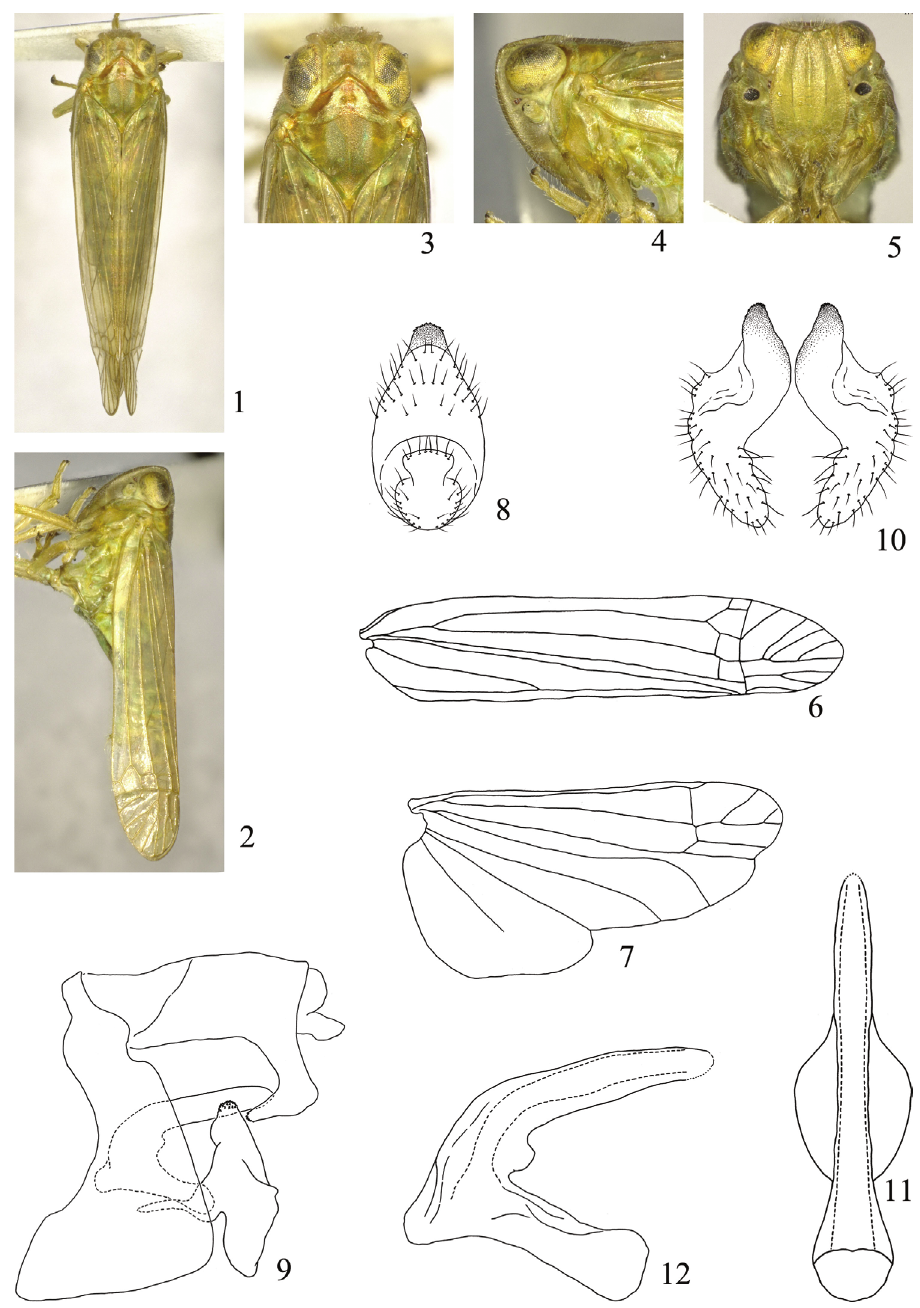
Figures 1–12. Symplanella recurvata sp. n. 1 Male habitus, dorsal view 2 Male habitus, lateral view 3 Head and thorax, dorsal view 4 Head and thorax, lateral view 5 Face 6 Forewing 7 Hindwing 8 Male anal segment, posterior view 9 Male genitalia, lateral view 10 Styles, posterior view 11 Aedeagus, dorsal view 12 Aedeagus, lateral